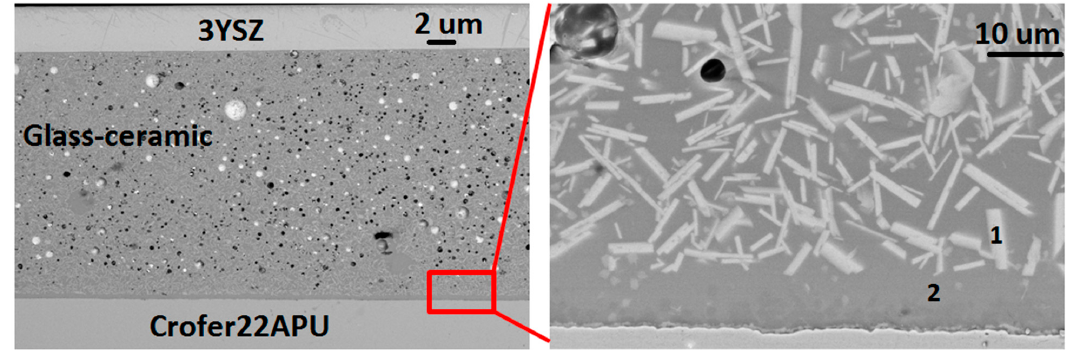
Figure 4. SEM images of as-joined Crofer22APU / HJ28 / 3YSZ joined samples. Table 3. EDS point analyses (at. %) performed on the HJ28 glass ‐ ceramics as shown in Figure 4.